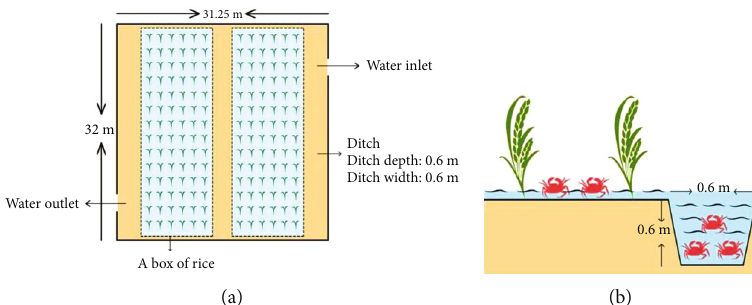
Figure 1: Schematic diagram showing the design of the experiment fi eld in the rice-crab culture systems. Note: (a) fl oor plan of the paddy fi eld; (b) stereoscopic view of the paddy fi eld. Each experiment fi eld comes equipped with a water inlet and a water outlet. Every 6 rows of rice are planted, and then 1 row is emptied to facilitate air circulation; 6 rows of rice are planted as one planting area to facilitate mechanical planting. 40